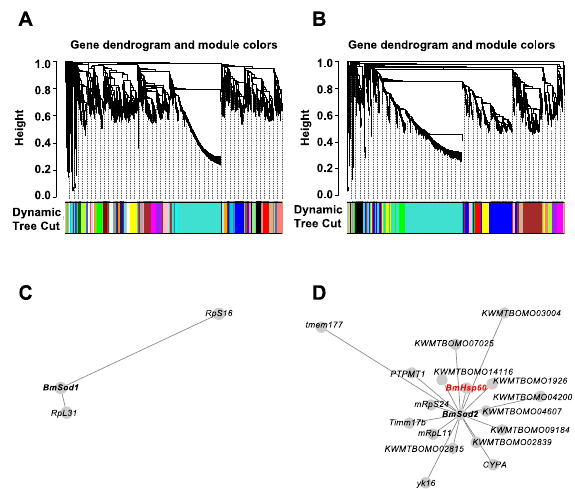
Figure 1. Gene co-expression analysis based on BmSod1 or BmSod2. ( A , B ); WGCNA results using genes encoding proteins predicted to be localized in the cytoplasm ( A ) or mitochondria ( B ) as inputs. In the clustering tree (dendrogram), each leaf (short vertical line) corresponds to a gene. Branches of the dendrogram show densely interconnected, highly co-expressed genes. Modules were defined as individual branches (”cutting the branches off the dendrogram”). ( C , D ); Network construction results using genes encoding proteins predicted to be localized in the cytoplasm ( C ) or mitochondria ( D ) as inputs. Each node indicates a gene. When two nodes are linked by an edge, the two genes are co-expressed. The length of an edge indicates the weight (i.e., the strength of the connection). BmHsp60 mRNA is highlighted in red.